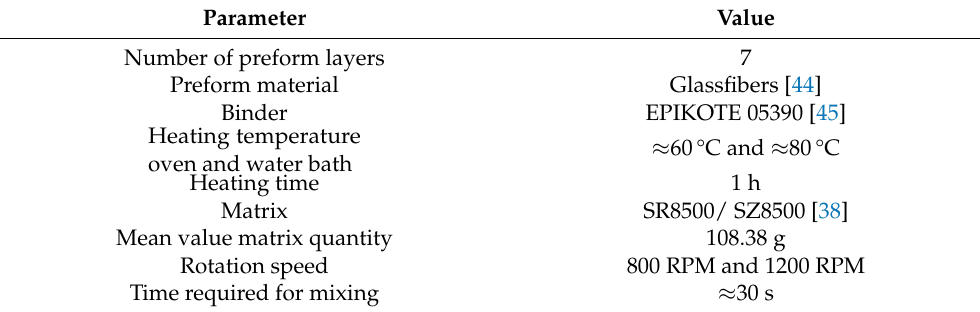
Figure 12. Sensor integration into the mold. Table 7. Manufacturing